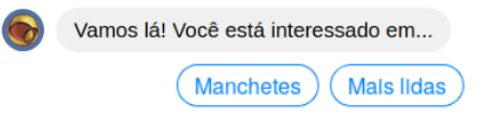
Fig. 20. Suggestions on the UOL Not´ıcias chatbot. Translation: –Let’s go! You are interested in...